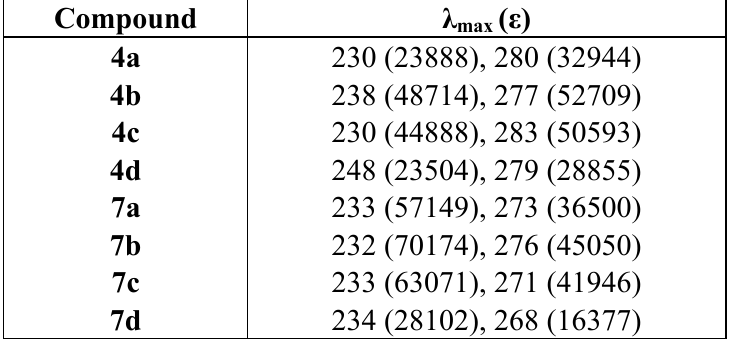
Table 1. λ and molar absorptivity ( ε ) for compounds 4a – d and 7a – d max